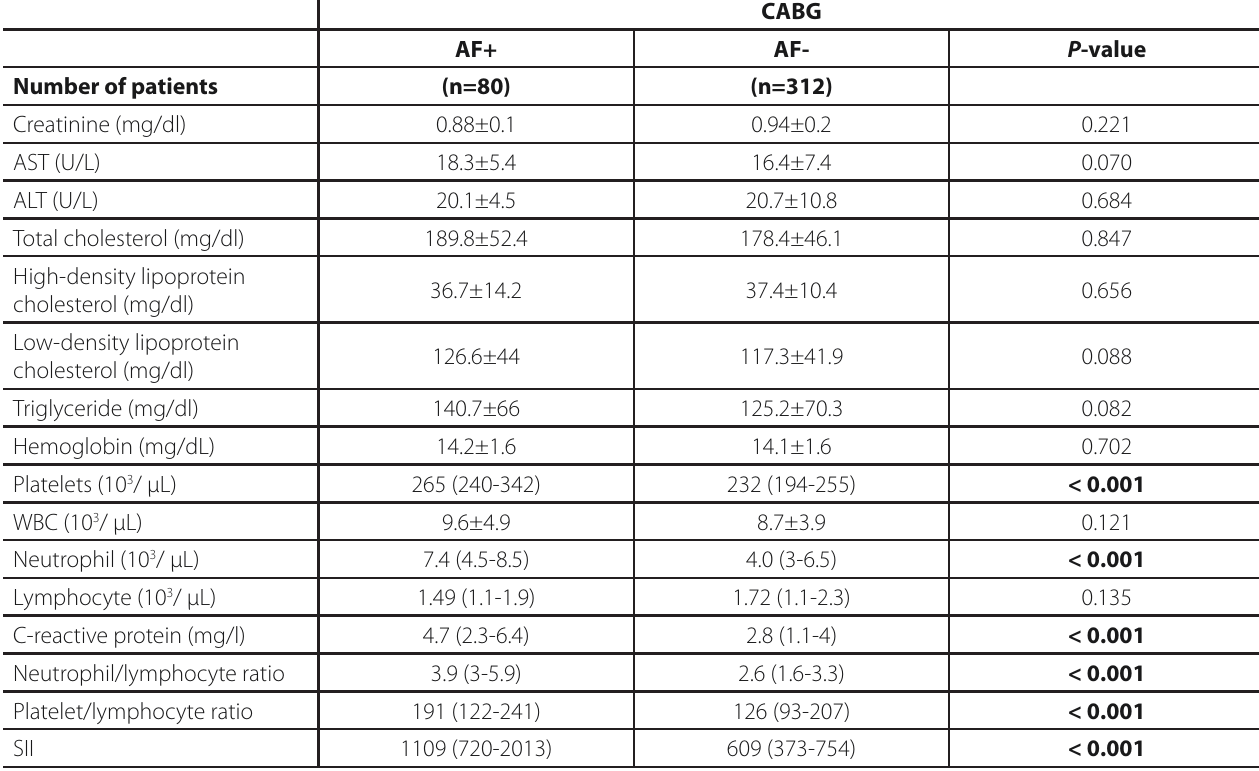
Table 2. Laboratory findings of the study populations.